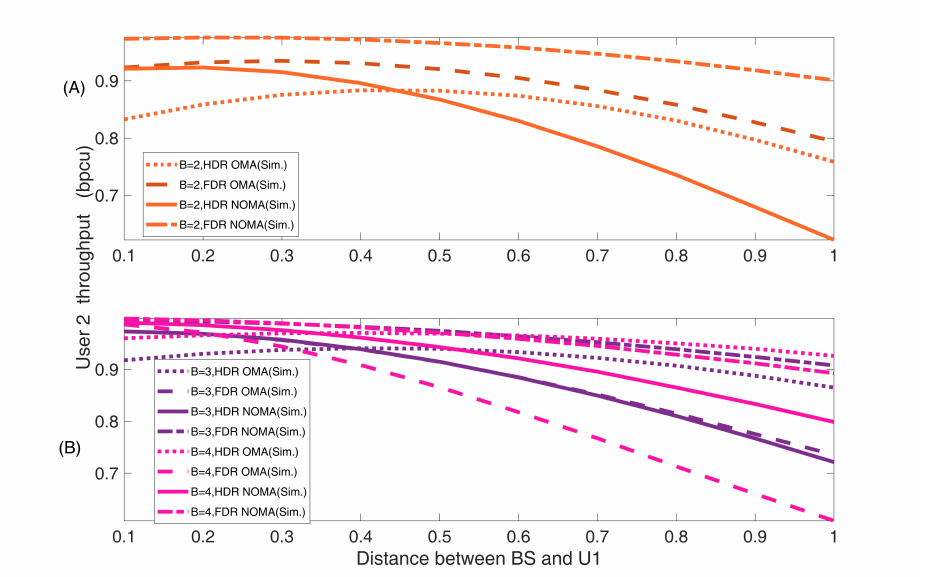
Figure 10. Cell-edge or far-user throughput versus distance of U 1 for UAV-HDR/FDR based-NOMA and OMA schemes ( E ( | h LI | 2 ) = − 15 dB